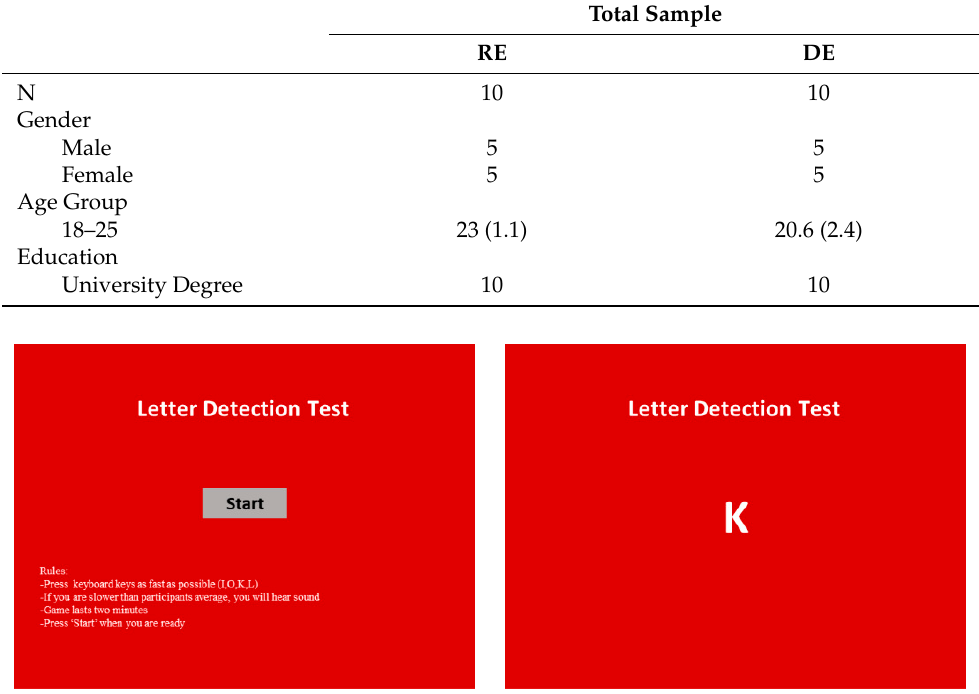
Table 1. List of the sociodemographic characteristics of the study participants.